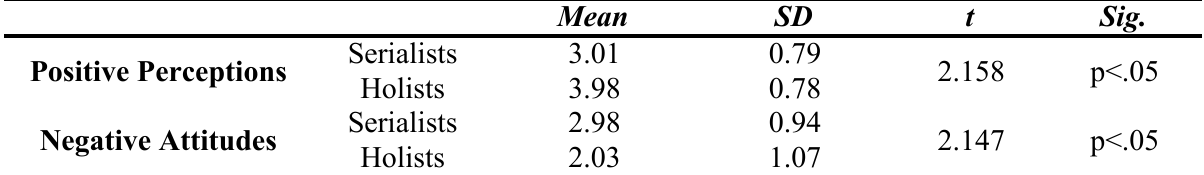
The Learning Perceptions for the PDLS